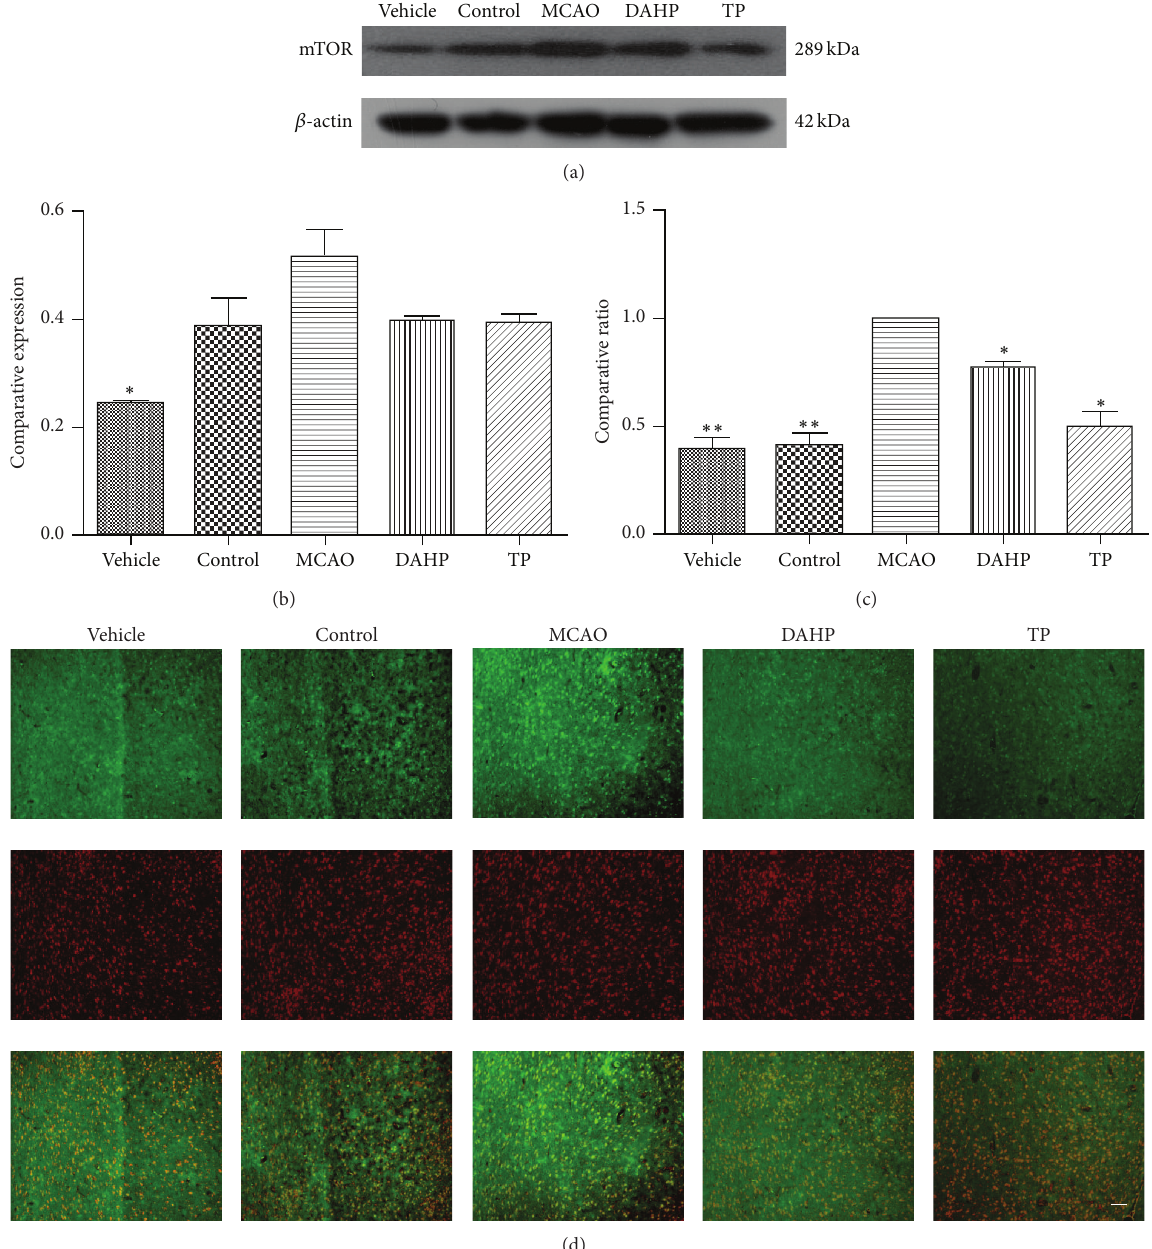
Figure5:mTORupregulationafterMCAOwasrevealedunderwesternblotandimmunofluorescentstaining.Westernblotanalysisofprotein levels of mTOR and 𝛽 -actin in the rat cortex derived from each group. (a) The images show that MCAO has an increase on vehicle, whereas DAHP and TP treatment groups are decreased. (b) Optical densities of respective protein bands were analyzed and normalized to the control ( 𝛽 -actin). Results were expressed as means ± SDs from three independent experiments. (c) From the histograms, the expression of mTOR in each group has a comparatively large fluctuation. Values are the means ± SEMs. ∗ 𝑃 < 0.05 ; ∗∗ 𝑃 < 0.001 ; ∗∗∗ 𝑃 < 0.0001 ; n.s.: no significance. (d) The immunofluorescent staining results were consistent with those of protein level differences, mentioned above in (a). MCAO has an increasing trend. Bar = 100 𝜇